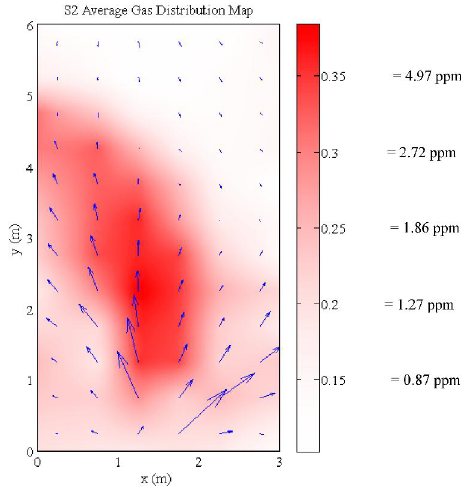
Figure 14. Average gas distribution map in testbed. The estimated ethanol concentration is described on the color scale.